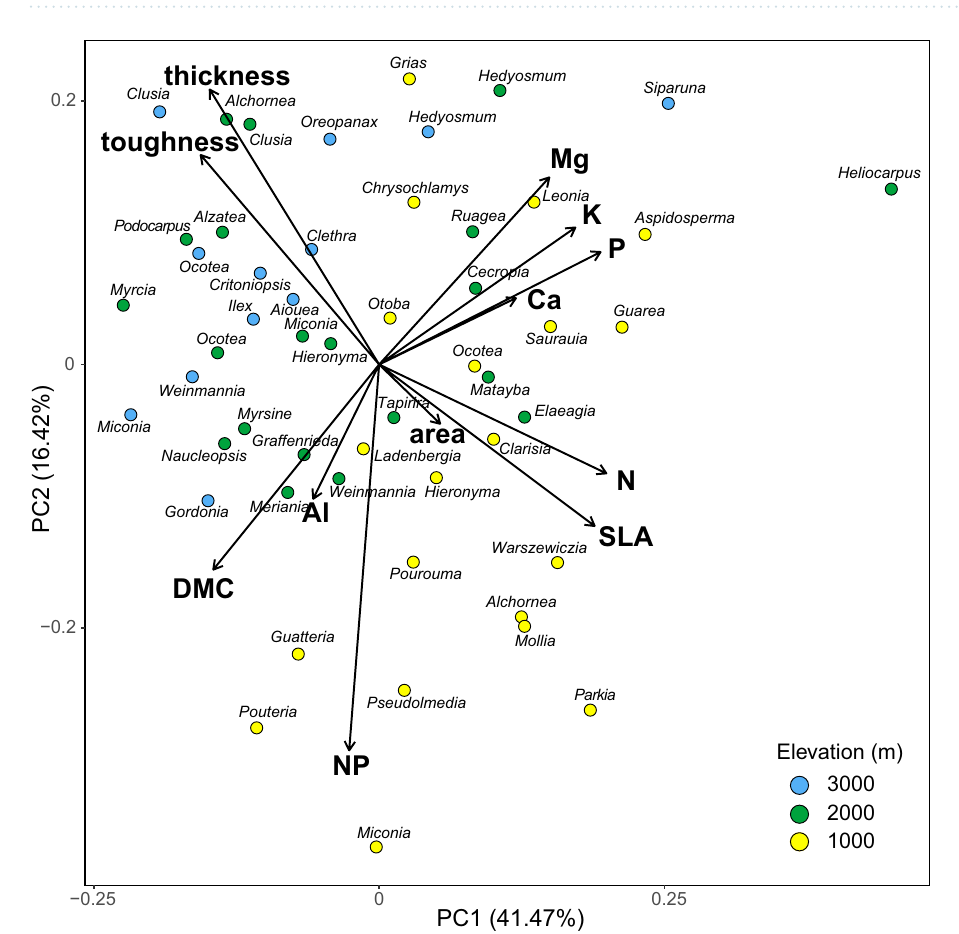
Figure 4. Principle components analysis (PCA) showing the distribution of the 52 tree species from the three study sites in the leaf trait